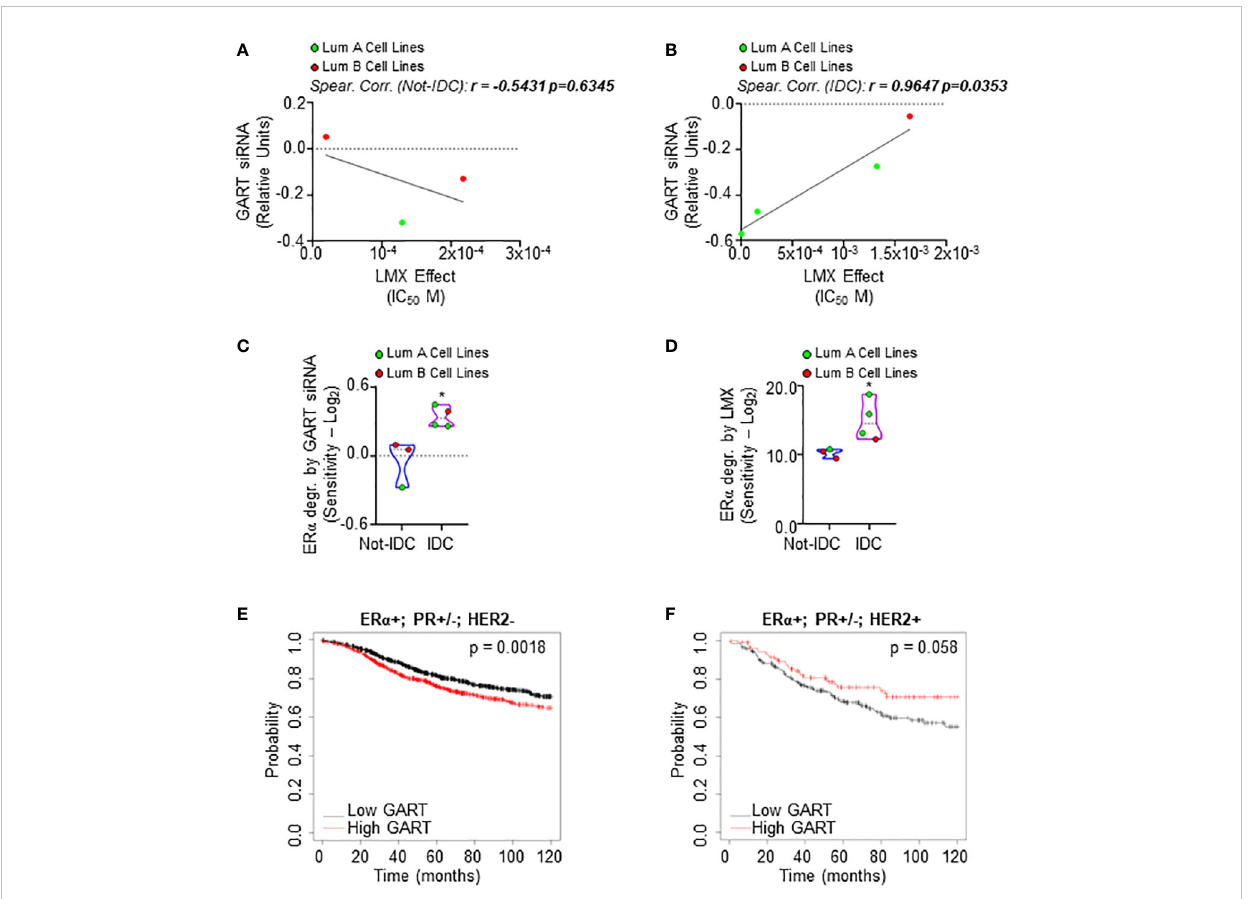
FIGURE 3 Sensitivity of luminal A ER a -positive invasive ductal carcinomas to GART inhibition. Linear regression and Spearman Correlation values between the sensitivity to GART siRNA-induced anti-proliferative effect as downloaded by the DepMap portal (https://depmap.org/portal) and the calculated inhibitor concentration 50 (IC 50 ) for lometrexol (LMX)-induced anti-proliferative effect in the same BC cell lines strati fi ed in luminal A (LumA, green dots) and luminal B (LumB, red dots) BC cell lines and in non-invasive ductal carcinomas (Not-IDC) (A) or invasive ductal carcinomas (IDC) (B) r and p-values are given in the main panels. The sensitivity to GART siRNA-induced (C) and lometrexol (LMX)-induced (D) ER a degradation effect as calculated by extrapolating the effective concentration 50 (EC 50 ) and -Log 2 transforming it in different BC cell lines strati fi ed as luminal A (LumA, green dots) and luminal B (LumB, red dots) and non-invasive ductal carcinomas (Not-IDC) or invasive ductal carcinomas (IDC). Kaplan-Meier plots showing the relapse-free survival (RFS) probability in women carrying breast tumors expressing ER a , both expressing or not progesterone receptor (PR) but not HER2 (E) or ER a , HER2 or both expressing or not PR (F) as a function of GART mRNA levels. Signi fi cant differences between the RFS are given as p -value in each panel. Data have been downloaded by the website (https://kmplot.com/analysis/). All possible cutoff values between